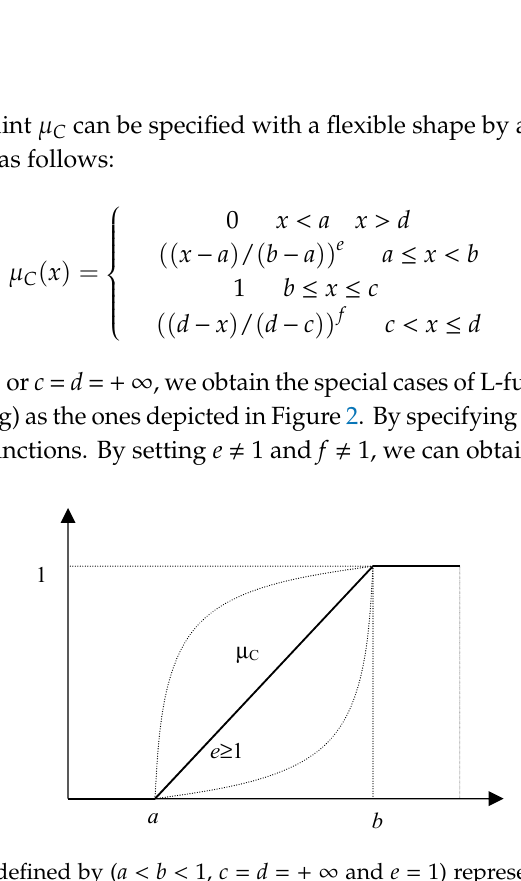
Figure 2. R-functions defined by ( a < b < 1, c = d = + ∞ and e = 1) representing the semantics of a soft constraint.